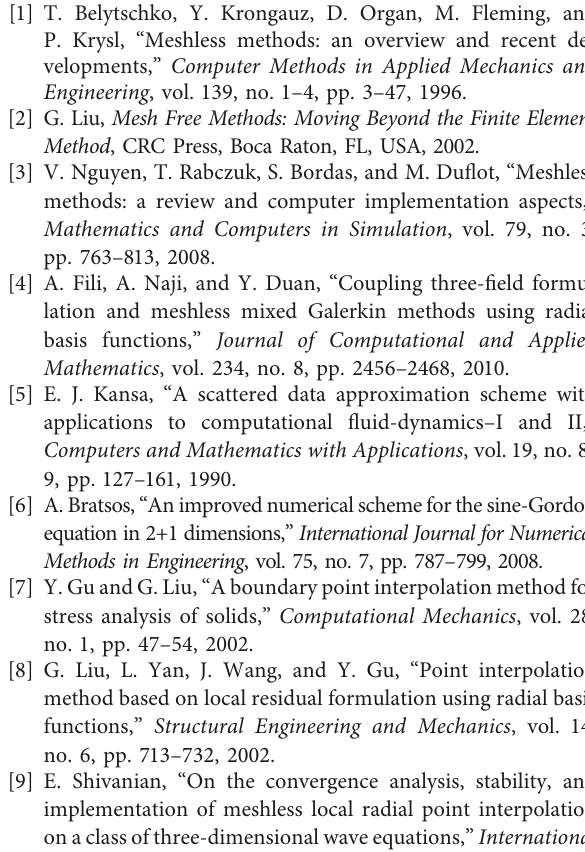
Figure 9: The profile of water depth and depth contours of the dam break over three humps at different output times: t t 30 s, and t (cid:29) (cid:29)